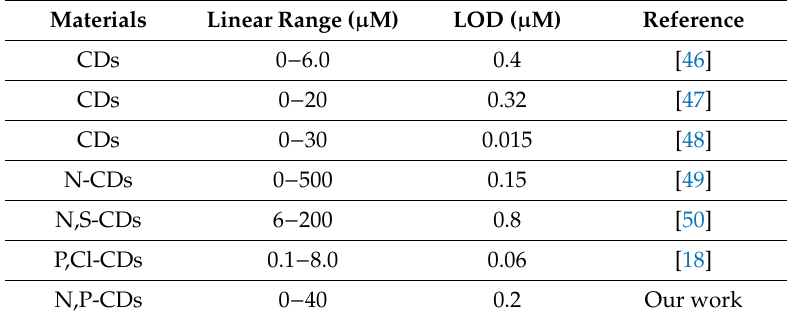
Figure 6. ( A ) Fluorescence spectra of NPCDs in the presence of different concentrations of Fe 3+ and ( B ) the linear relationship between I NPCDs+Fe3+ / I NPCDs and the concentration of Fe 3+. Table 2. Comparison of different fluorescence probes for Fe 3+ detection.